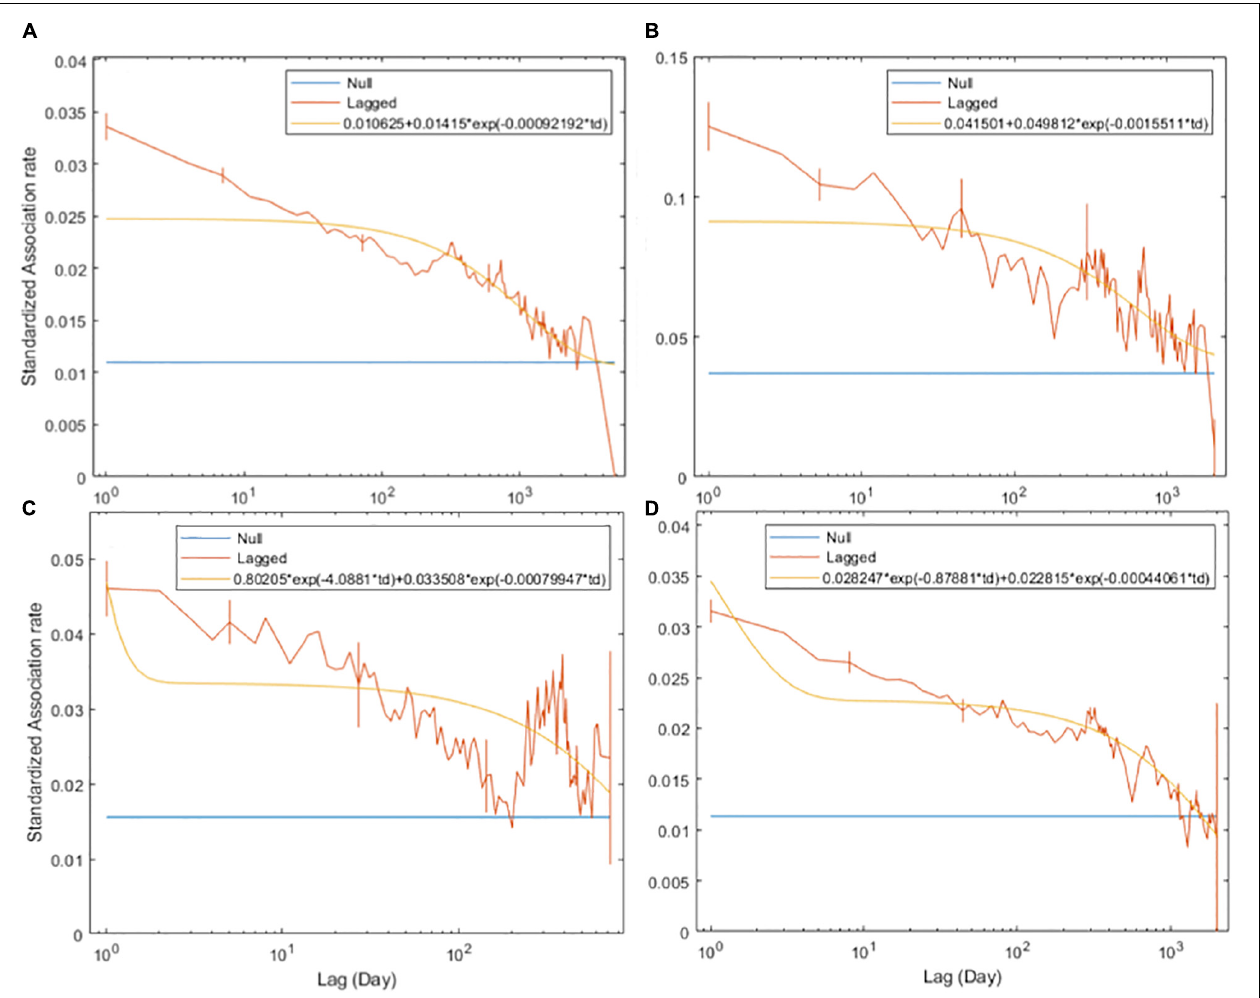
FIGURE 2 | Standardized lagged association rates (SLARs) of individual bull sharks encountered for the time periods 2003–2016 (A) , before 2009 (B) , between 2009 and 2010 (C) , and from 2011 (D) . Vertical bars indicate standard errors calculated using the temporal Jackknife method. The yellow line illustrates the best fit model characterizing the social system within the network whilst the blue line represents the null association rate, which is the theoretical SLAR if individual bull sharks were randomly